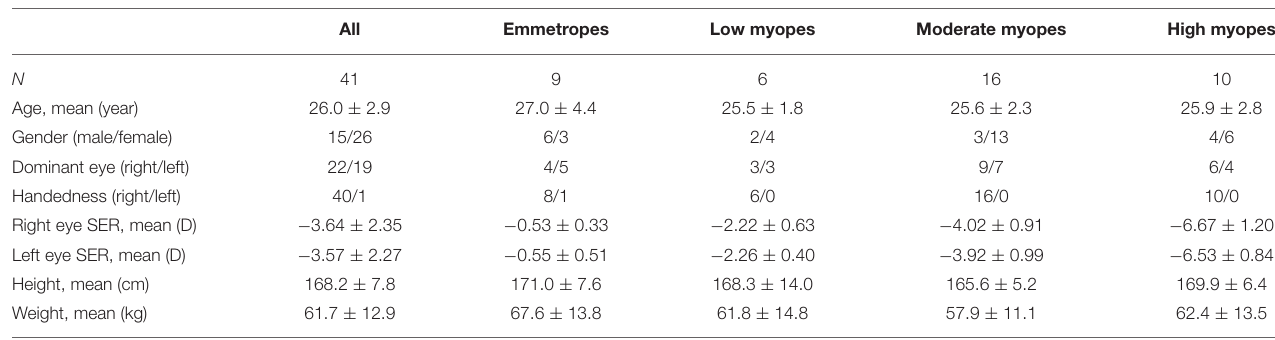
TABLE 1 | Characteristics of the subjects.